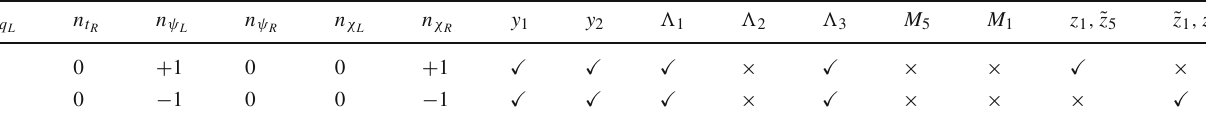
Lagrangian, together with the information on whether they are com- patible ( (cid:2) ) or not ( × ) with the PQ symmetry. This assignment can be trivially extended to the bottom